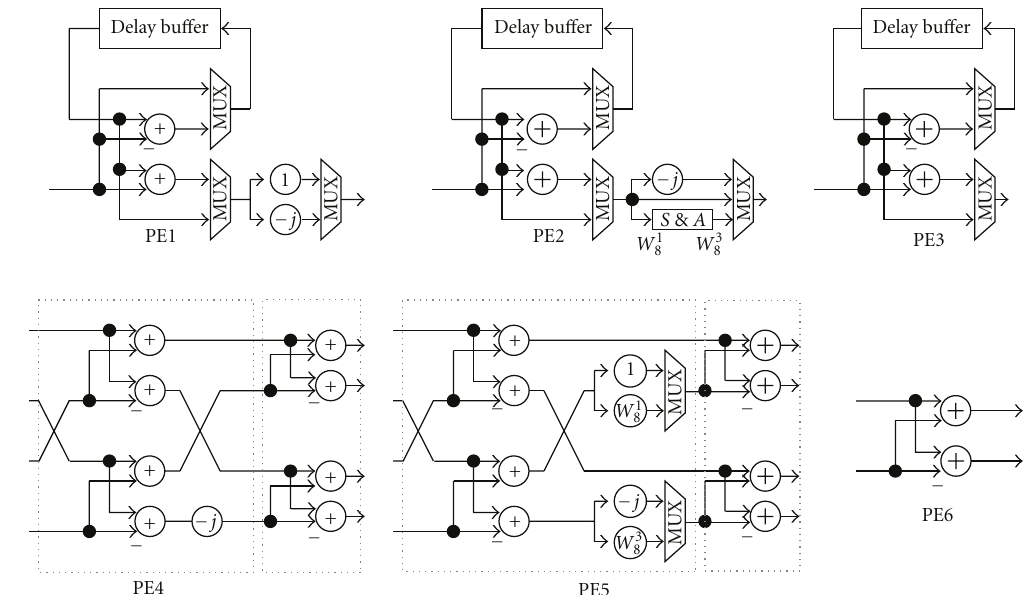
Figure 2: Block diagram of basic arithmetic processing elements.